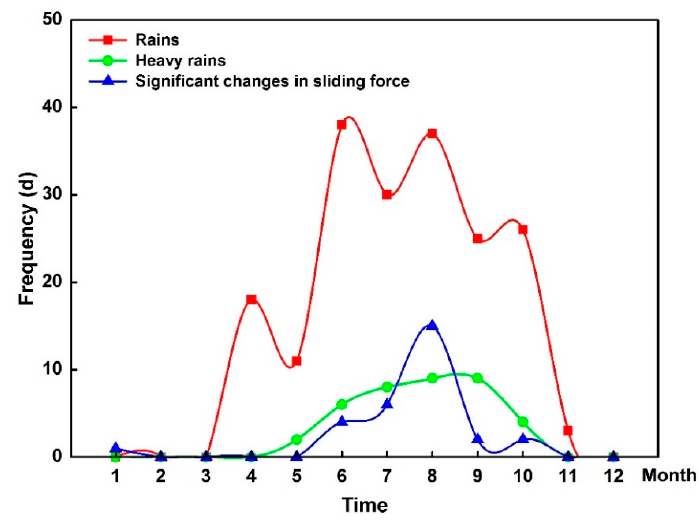
Figure 2. Frequencies of significant changes in sliding force, rain, and heavy rain during two years.